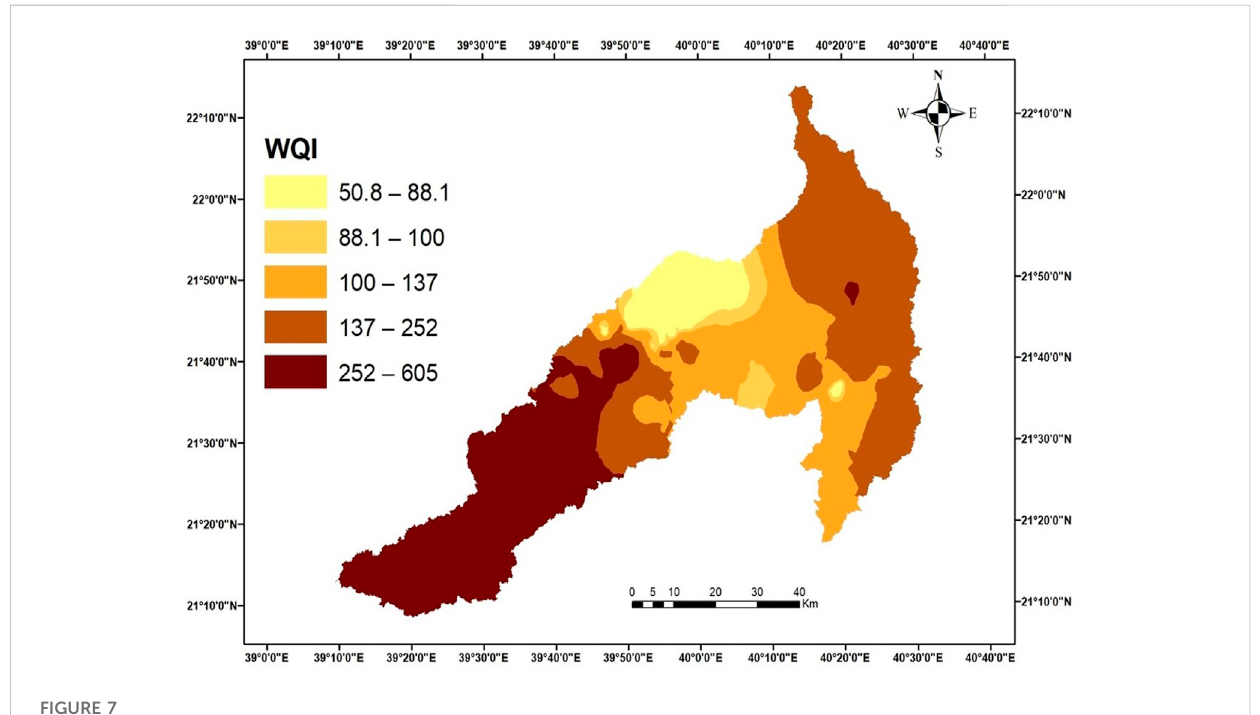
FIGURE 7 Water quality index spatial